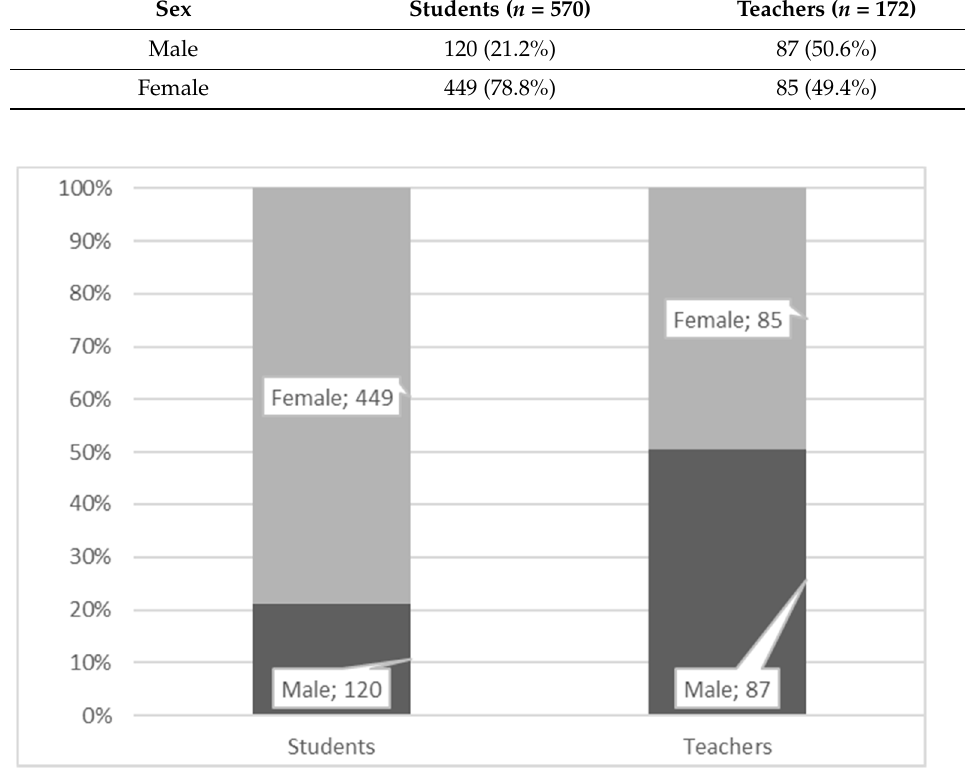
Table 4. Students and teachers, by sex.